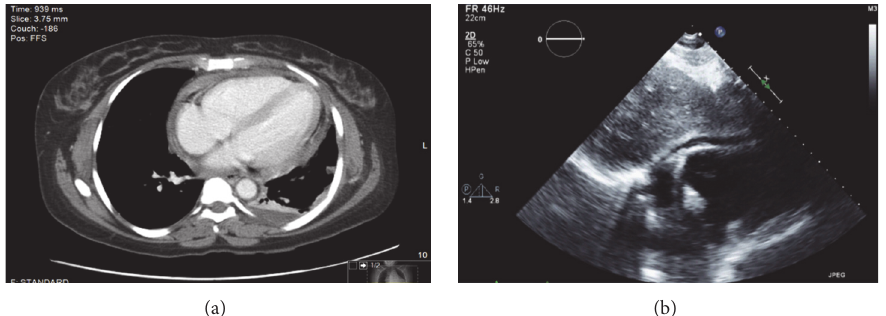
Figure 2: (a) Small pericardial effusion. Subsegmental atelectasis at the left lower lobe. Small left pleural effusion; previous right pleural effusion has resolved. (b) Parasternal long-axis echocardiogram showed small pericardial effusion with no evidence of echo cardiac